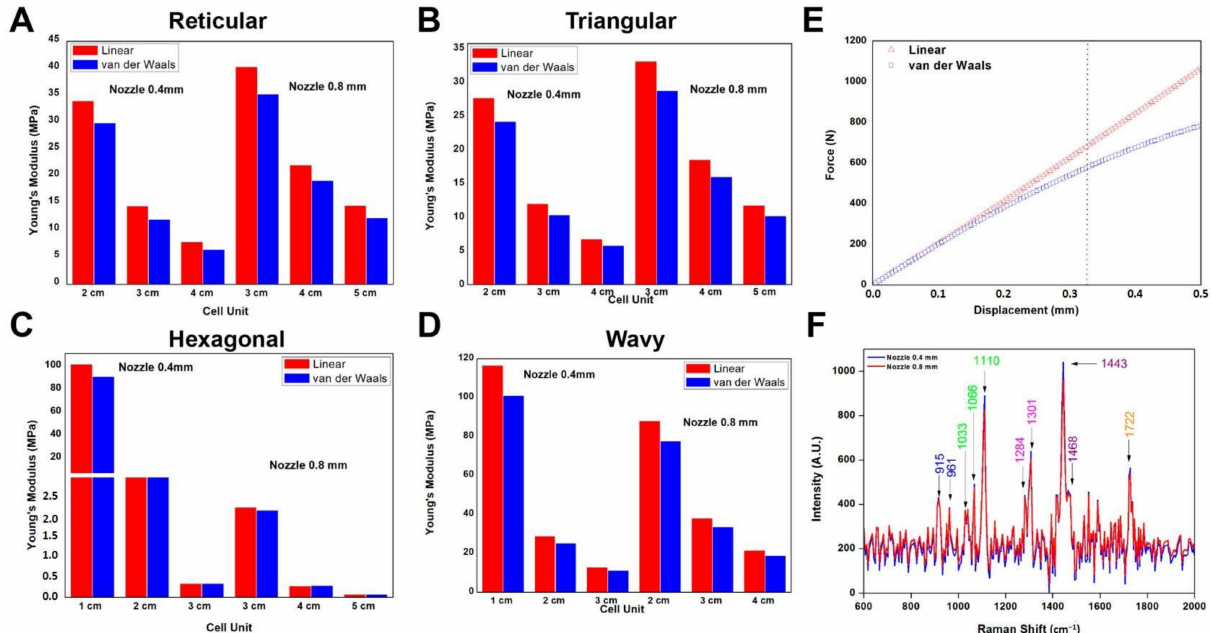
Figure 6. FEM prediction of compressive behavior of PCL scaffolds with van der Waals models. ( A – D ) Estimation of compressive moduli of scaffolds with different geometries using nonlinear vs. linear model; ( E ) prediction of nonlinear compressive behavior of lattice structure using van der Waals hyperelastic model and its comparison with linear compression data. ( F ) Raman spectroscopic analysis of lattice scaffold made of PCL printed with 0.4 mm (in blue) and 0.8 mm (in red) nozzle diameters. (A.U., arbitrary unit).